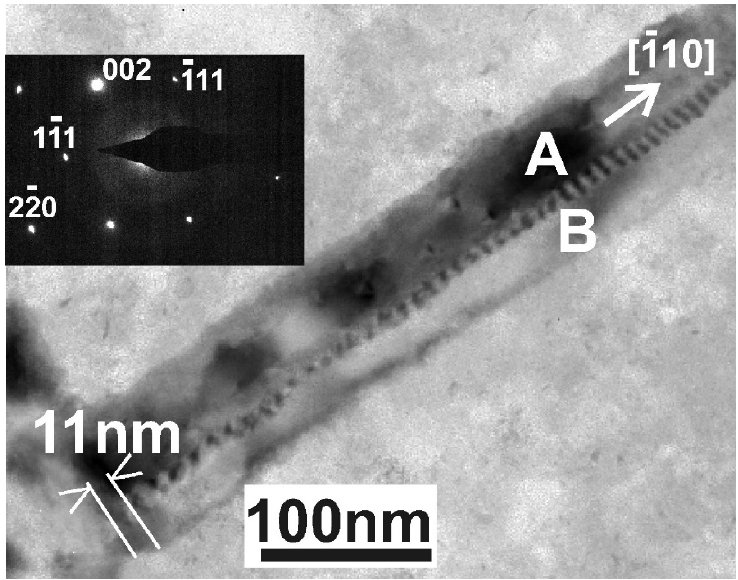
Figure 7. TEM micrograph of two partially overlapping parallel whiskers A and B. The related dif- fraction pattern in the inset reveals that the parallel whiskers A and B are in the (110) section, grown along the [110] direction, and therefore are of the slow type.